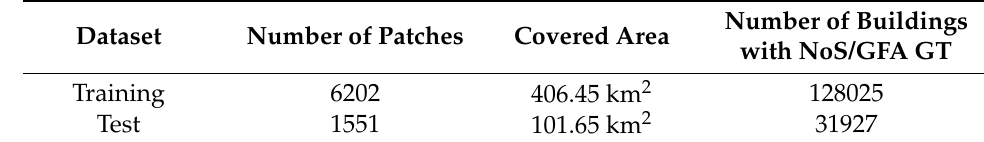
Figure 4. Image in dataset for high buildings.